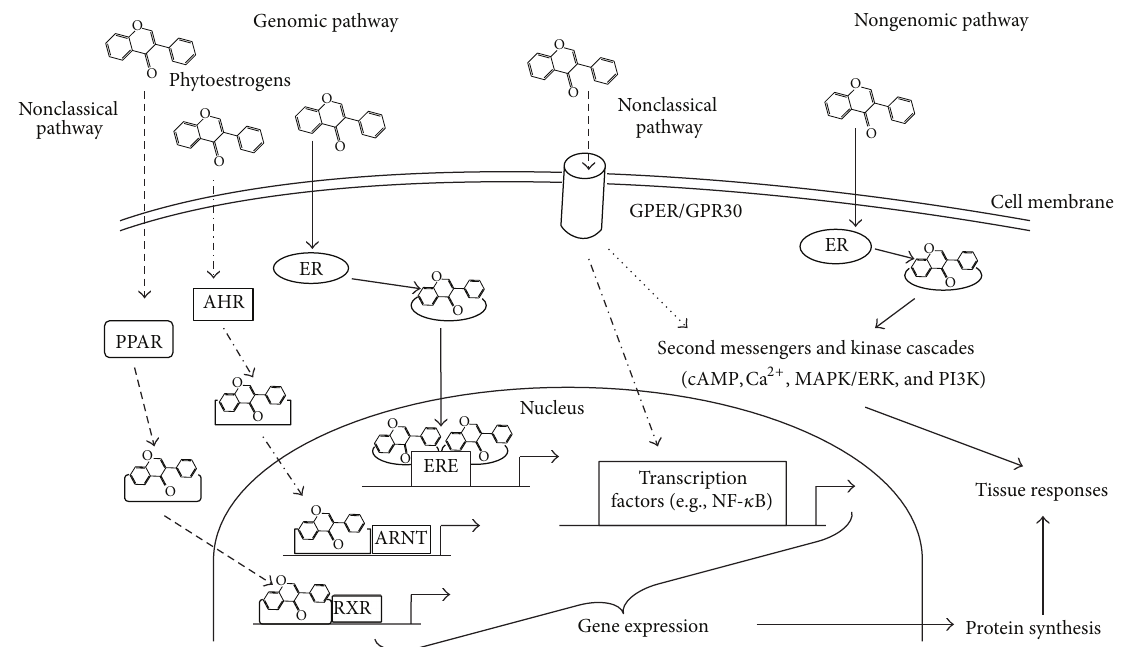
Figure 2: Schematic model illustrating the possible mechanisms of phytoestrogen action (the abbreviations on the figure stand for: AHR— aryl hydrocarbon receptor; ARNT—AHR nuclear translocator; ER—estrogen receptor; ERE—estrogen response element; cAMP—cyclic adenosine monophosphate; Ca 2+ —calcium ions; GPER/GPR30—G protein-coupled estrogen receptor 1; MAPK/ERK—mitogen-activated protein kinases/extracellular-signal-regulated kinases; NF- 𝜅 B—nuclear factor kappa-light-chain-enhancer of activated B cells; PI3K— phosphatidylinositide 3-kinases; PPAR—peroxisome-proliferator-activated receptor; RXR—retinoid X